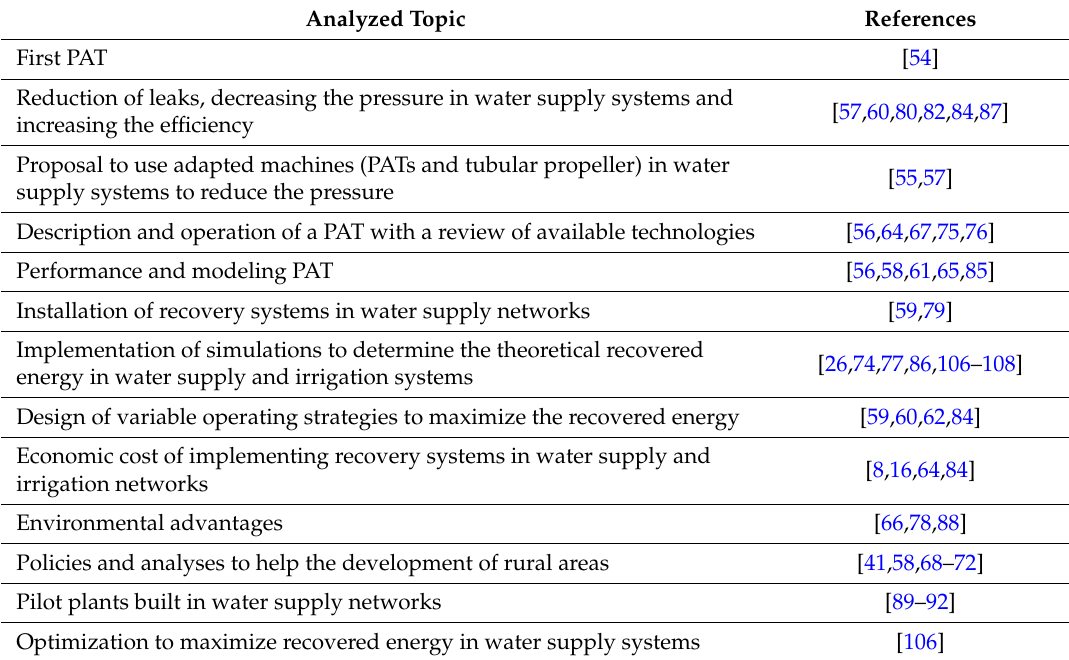
Table 1. Analyzed topics related to recovery systems in water supply networks. Analyzed